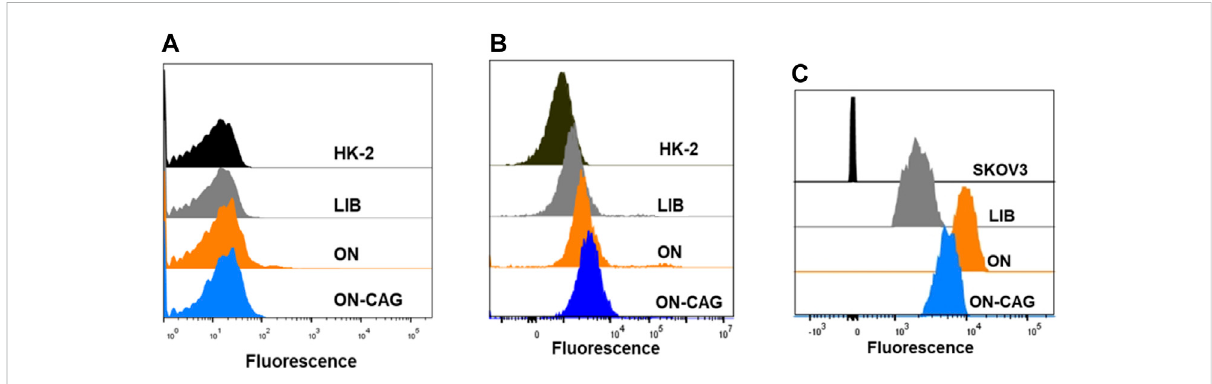
FIGURE 4 Binding ability of ON-CAG. The cellular uptake of ON-CAG-FAM in normal HK-2 cells (A) cisplatin-induced HK-2 cells (B) and SKOV3 cells (C) monitored by fl ow cytometry.